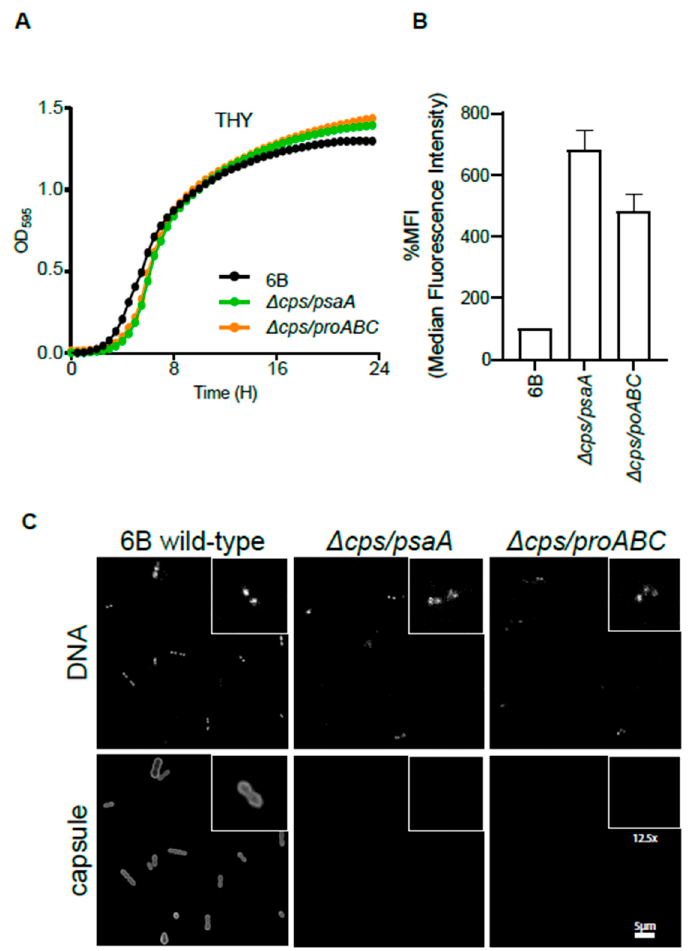
Figure 1. Phenotypic characterization of double unencapsulated mutants ∆ cps/psaA and ∆ cps/proABC . ( A ) Growth of wild type and unencapsulated strains ∆ cps/psaA and ∆ cps/proABC in THY assessed by measuring OD595 for a 24 h period. ( B ) Effect of the S. pneumoniae capsule on C3b deposition. Median fluorescence intensity (MFI) of C3b deposition measured using flow cytometry on the wild type 6B and unencapsulated mutants when incubated in 25% human serum. Error bars represent SDs and asterisks represent the differences between wild type and the unencapsulated mutant strain. For both mutant strains, p is < 0.0001 (one way ANOVA) compared to the wild type strain. ( C ) Fluorescent microscopy of wild type and unencapsulated double mutant strains following incubation with 4 ′ ,6-diamidino-2-phenylindole (DAPI) (binds to DNA to identify bacterial cells, top panels) or pneumococcal antiserum labelled with Alexa fluor 546 (recognizes serotype 6 capsule, bottom panels). The scale bar (bottom right) represents 5 µm and the inserts show a 12.5 higher magnification of selected bacteria.